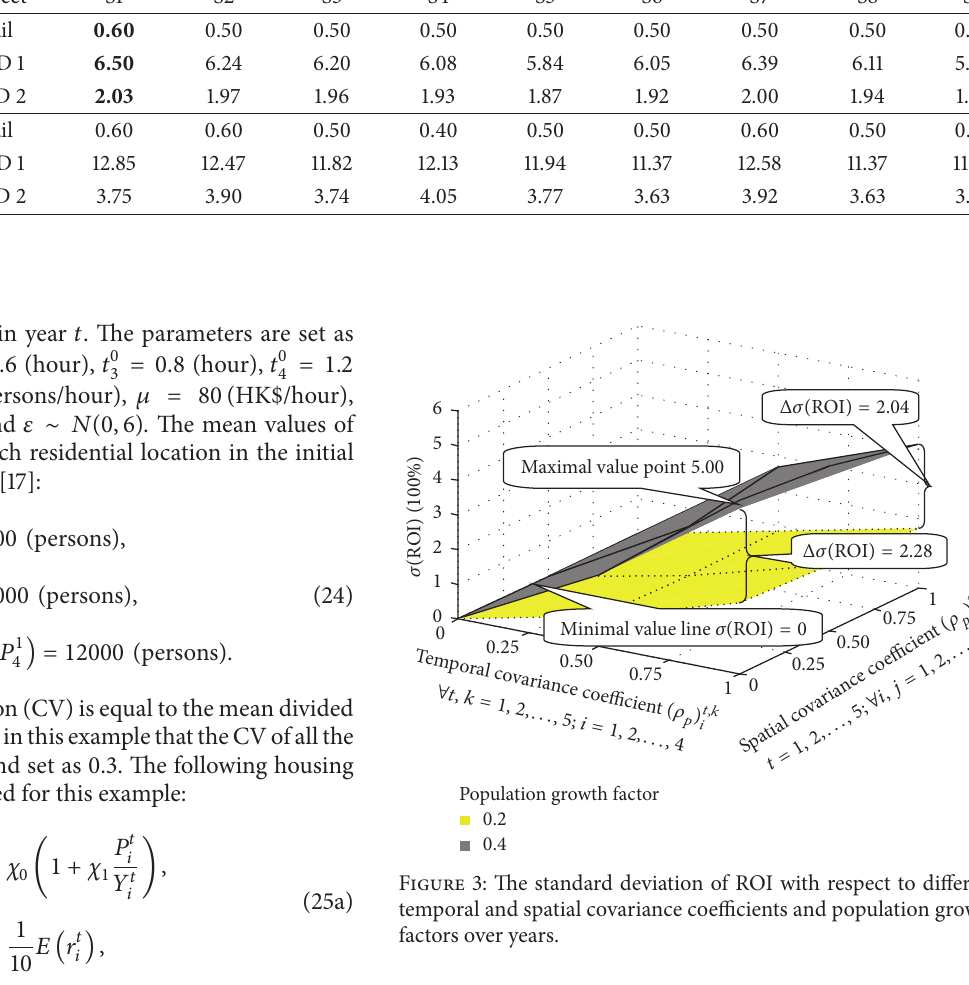
covariance increases from 0 to 1. 𝜎( ROI ) increases as the population growth factor of total population increases from 0.2 to 0.4. The maximal value point of 𝜎( ROI ) is 5.00 for population growth factor 0.4. The difference of 𝜎( ROI ) under population growth factors 0.2 and 0.4, Δ𝜎( ROI ) , is 2.28, with respect to temporal covariance coefficient 1 and spatial covariance coefficient